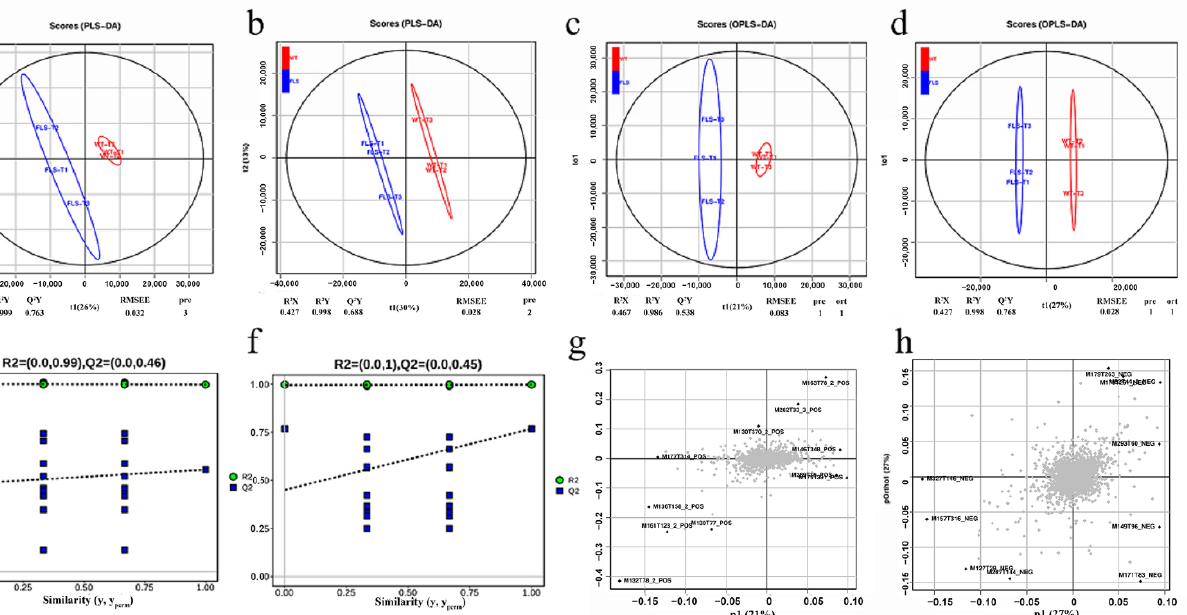
Table 3. Main differentially expressed metabolites related to flavonoid biosynthesis in WT and RuFLS2-OX tobacco.